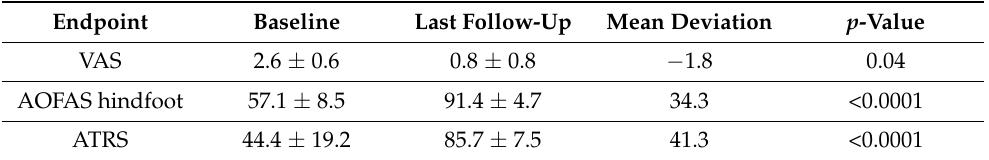
Table 4. Patient-reported outcome